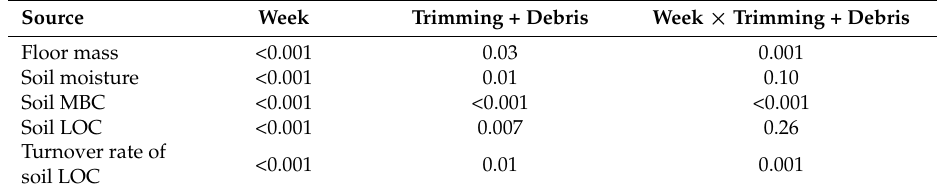
Table 2. Effects of canopy trimming and debris deposition (CTDD) treatment and time after the CTDD treatment as well as their interactions on floor mass, soil moisture, soil MBC, soil LOC, and the turnover rate of soil LOC by the mixed-model ANOVA in the Luquillo Experimental Forest, Puerto Rico. The within-subject factor is week. The dependent variables are floor mass, soil moisture, soil MBC, soil LOC, and turnover rate in the CTDD plots. Independent variables are treatment (control vs. CTDD